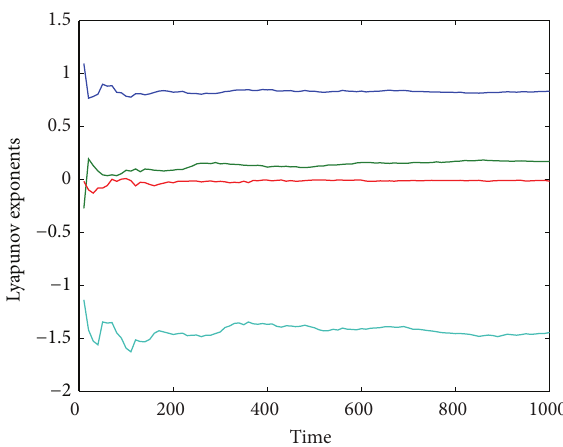
Figure 2: Hyperchaotic attractor in 𝑥 1 − 𝑥 2 plane.